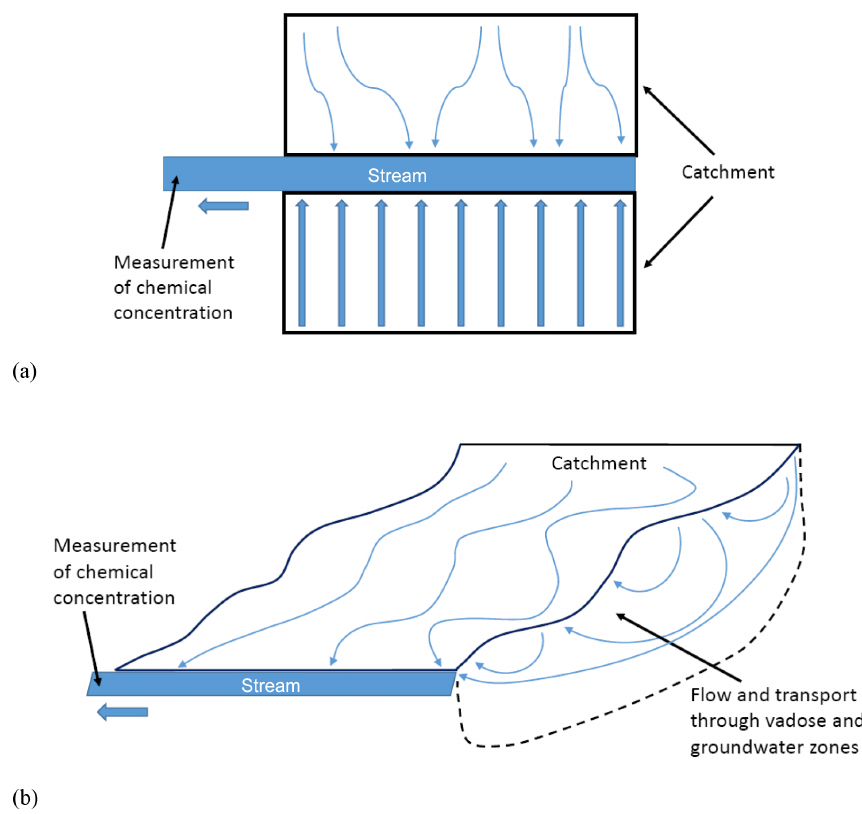
Figure 6. Conceptual pictures of water flow and chemical transport in catchments under a pulse of rainfall over the entire catchment. Each curved arrow (or idealized straight arrow) indicates a different path, each of which embodies different travel times through the system until reaching the stream. Note that each preferential pathway carrying water and chemical species may be purely overland or include interactions and advance within soil layers (partially saturated, or vadose, zone) and saturated groundwater systems. (a) Schematic showing idealized 2D catchment area. Arrows through two rectangular regions of catchment indicate a range of preferential pathways carrying water and chemical species. (b) Schematic showing idealized 3D catchment area, under a pulse of rainfall over the entire